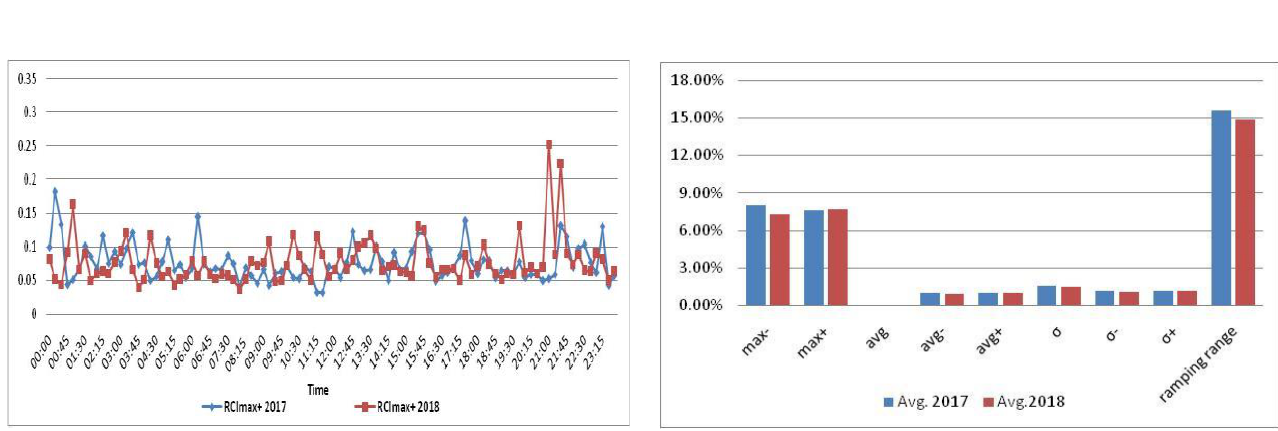
Figure 19. Comparison between RCI for maximum values of upward power ramps in 15 min interval at each observation time t for the years 2017 and 2018.